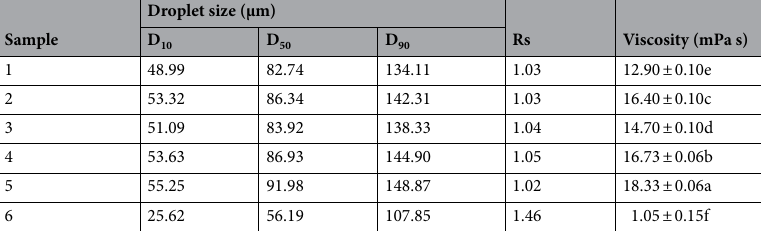
Table 4. Droplet size and droplet size distribution of different sample sprays. D 10 : 10% cumulative volume diameter,